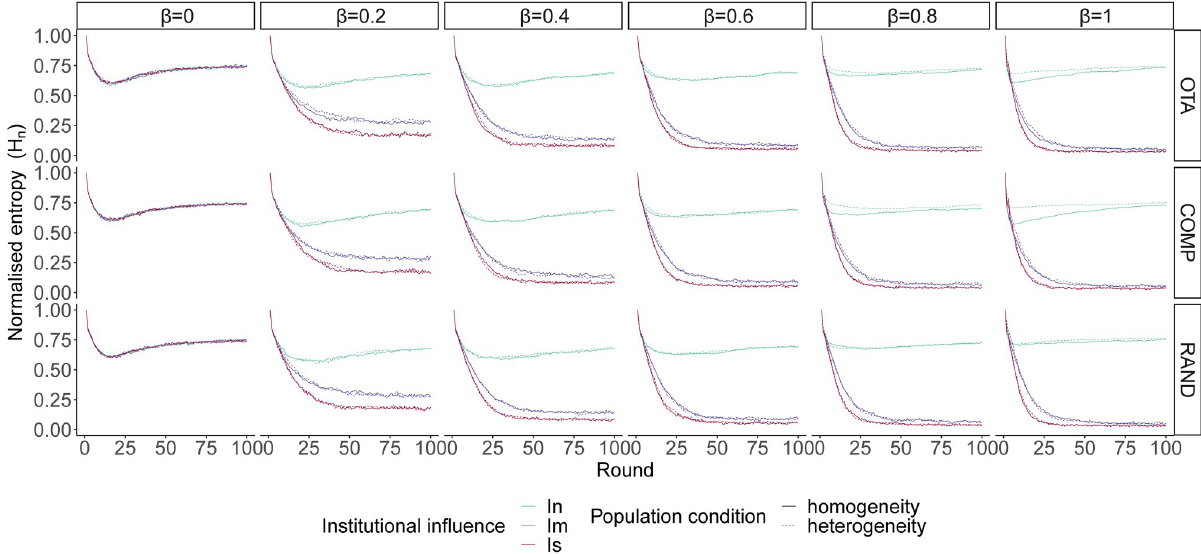
Fig 4. Opinion diversity (measured as normalised Shannon entropy) under opinion-aggregating institutions, averaged over each level of = neutral; I = moderate and I = strong), population homogeneity or heterogeneity and opinion value bias ( β ) under institutional influence ( I n m s three types of value systems: OTA (one takes all), COMP (competition between two opinions) and RAND (random). Agents tend to converge on a shared opinion when institutional influence is moderate or strong. Under strong institutional influence convergence occurs at a faster rate. Convergence on shared opinions accelerates as β increases.